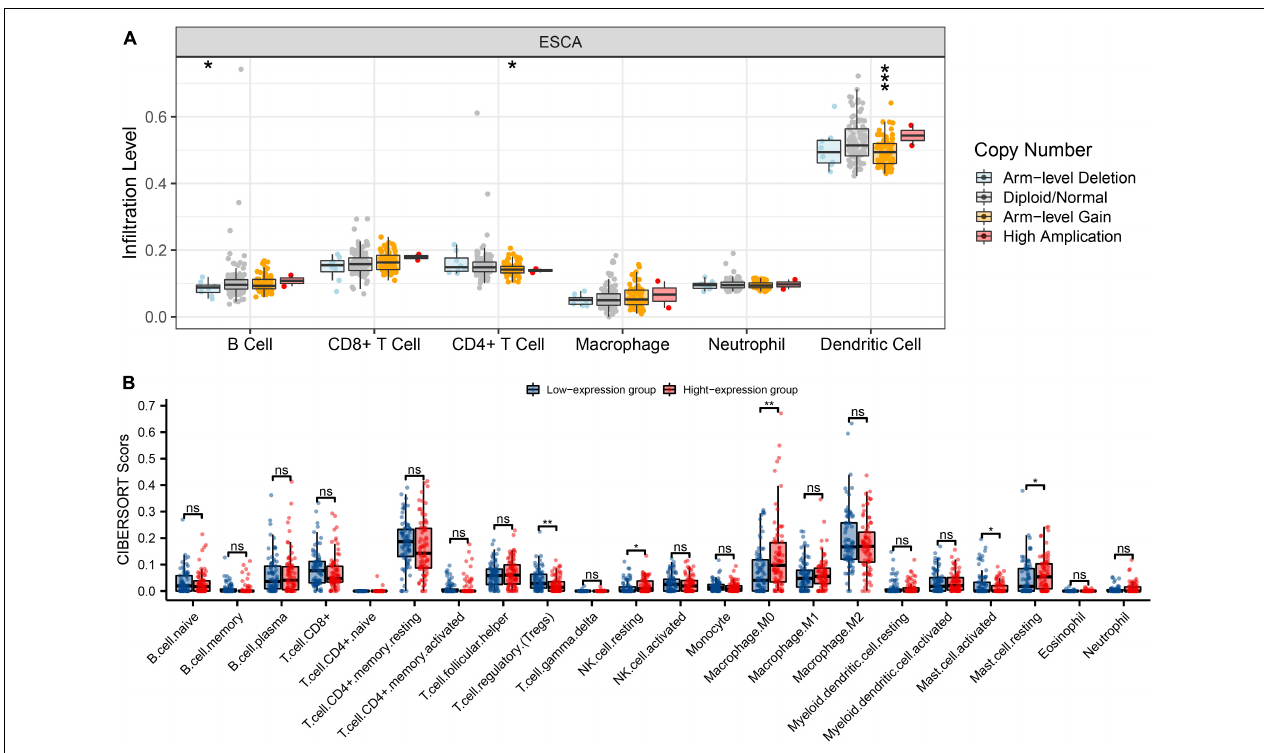
FIGURE 6 | Genetic copy number variations (CNV) of HK2 with the relative abundance of tumor infiltrating cells and CIBERSORT analysis. (A) HK2 CNV affects the infiltrating levels of CD4 + T cells, neutrophils, and dendritic cells in ESCA. (B) The change ratio of 22 immune cell subtypes in the high and low HK2 expression groups in ESCA tumor sample. * P < 0.05; ** P < 0.01; *** P < 0.001; ns, no